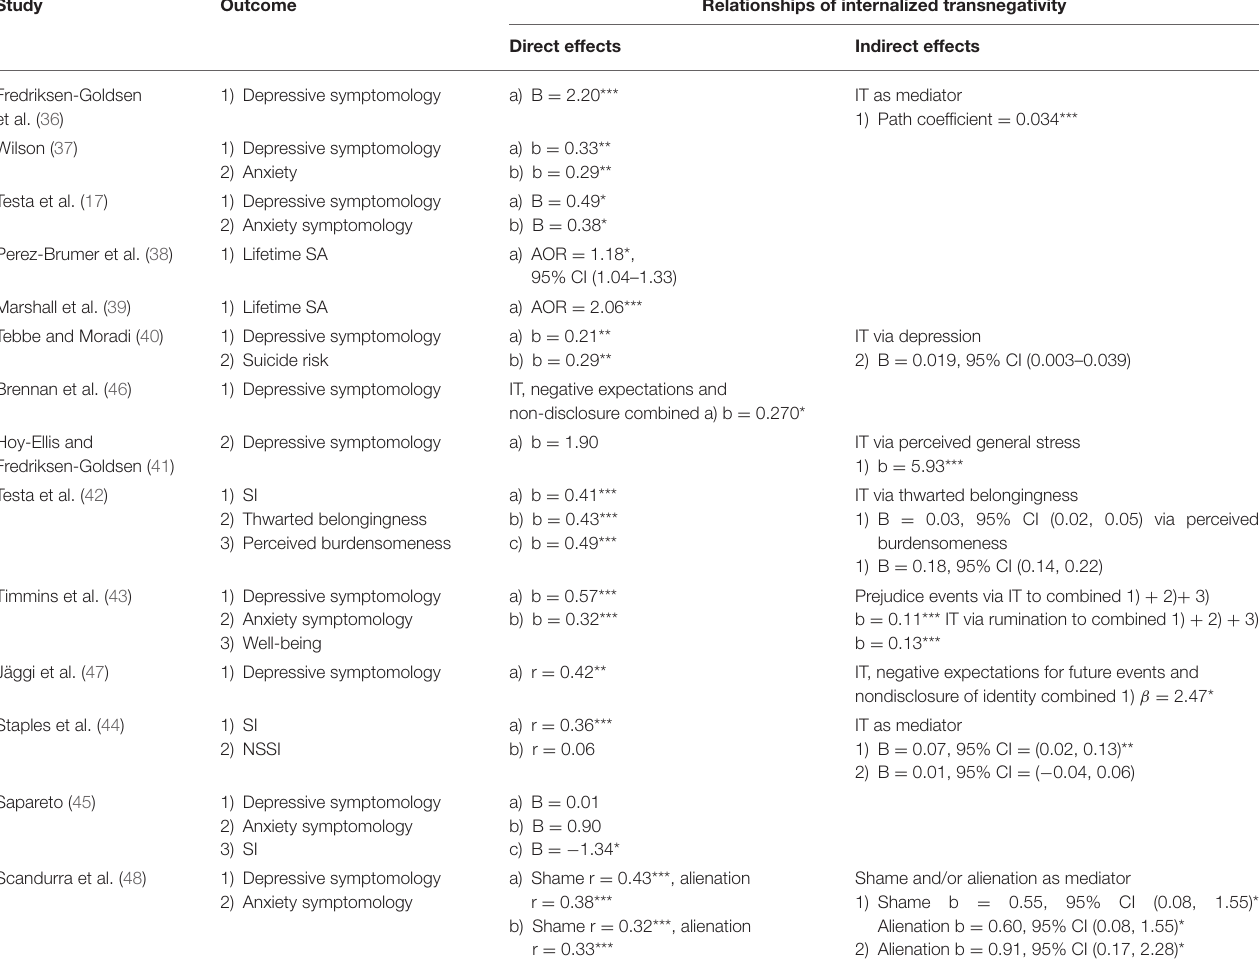
TABLE 8 | Results overview, internalized transnegativity. Study Outcome Relationships of internalized transnegativity Direct effects Indirect